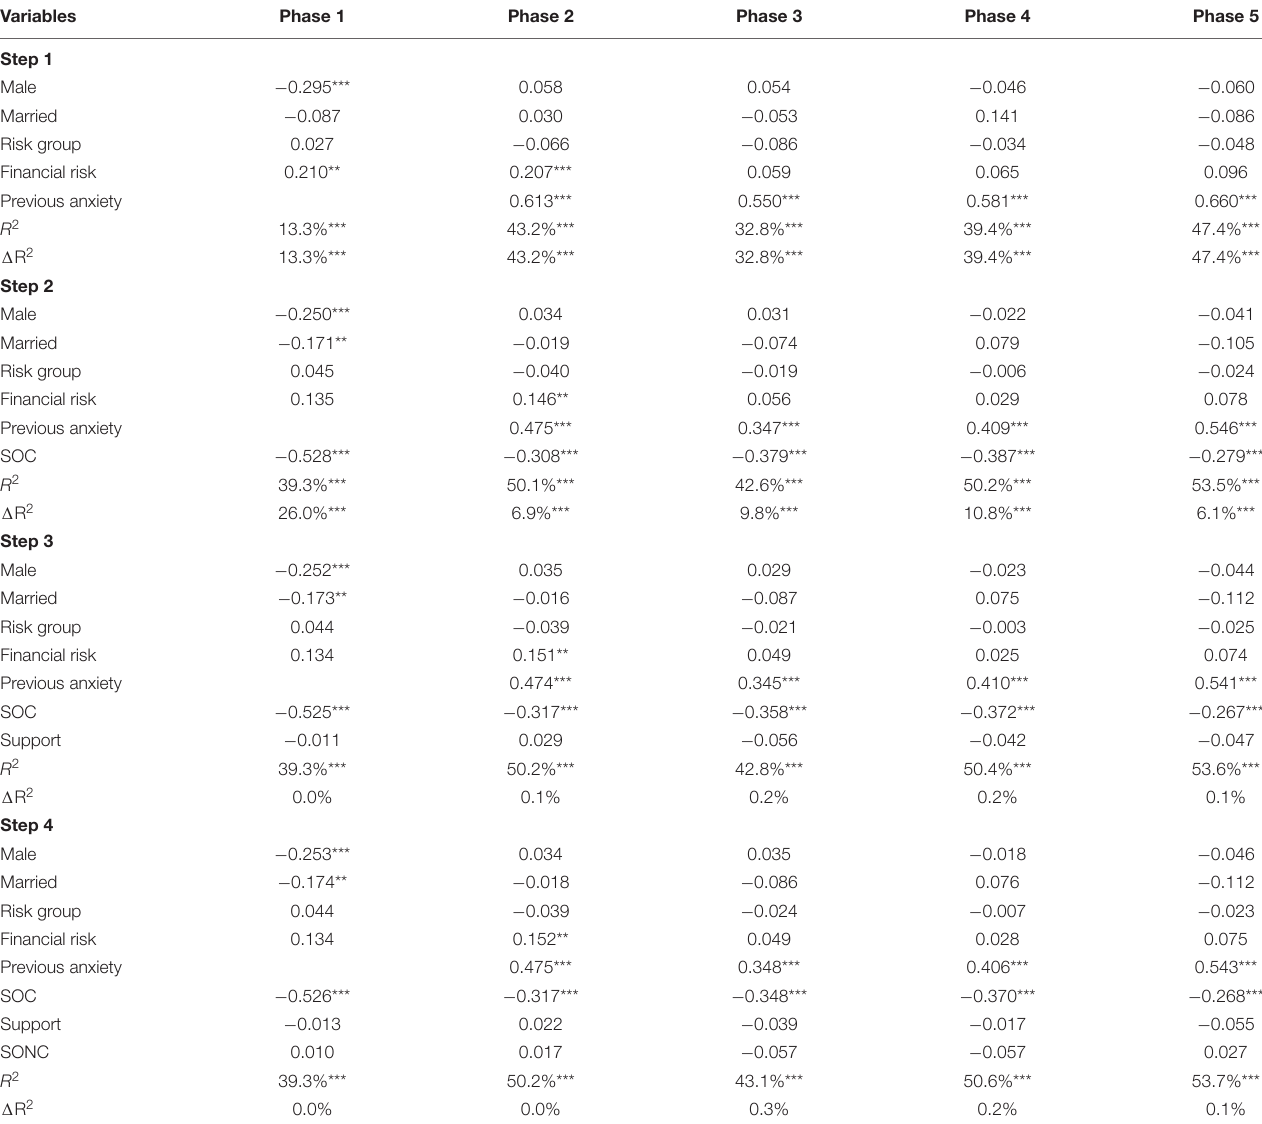
TABLE 4 | Beta values for predicting anxiety by coping resources and situational and demographic variables, separately for each